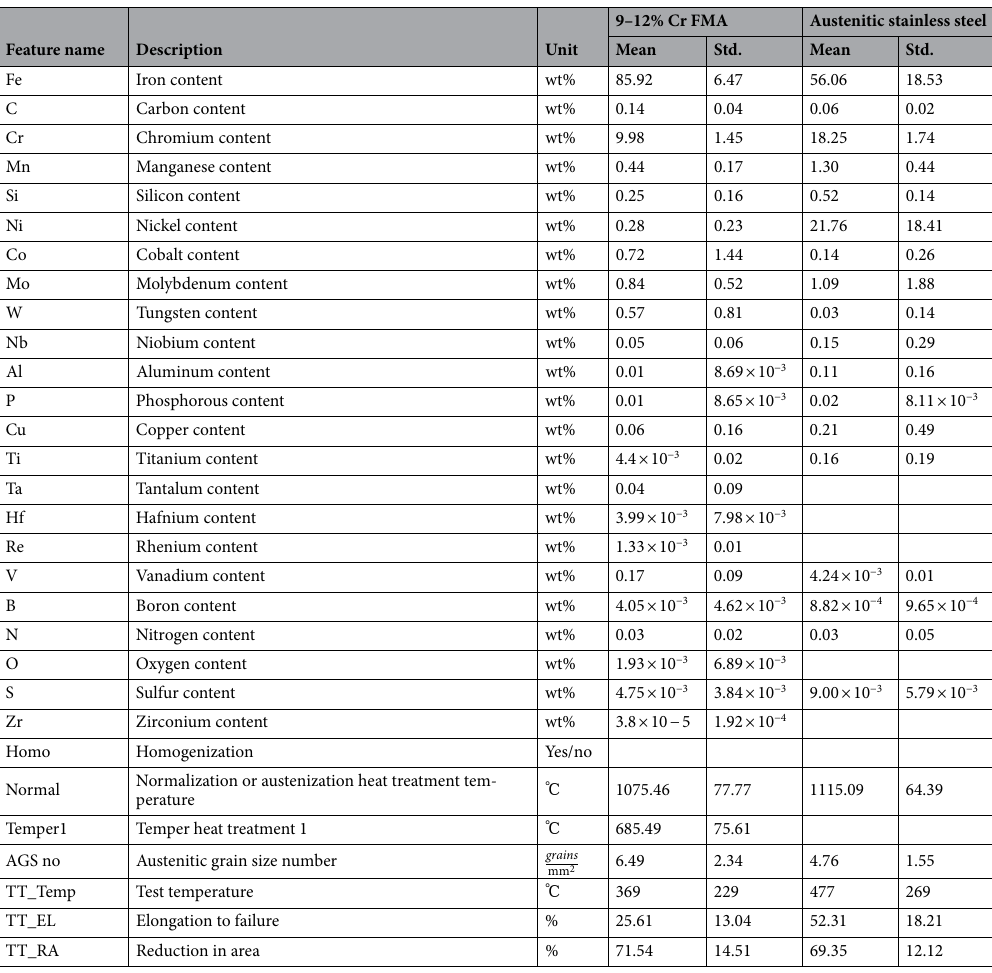
Table 1. Summary of the features present in both datasets, including feature name, description, units, mean values, and standard deviations.